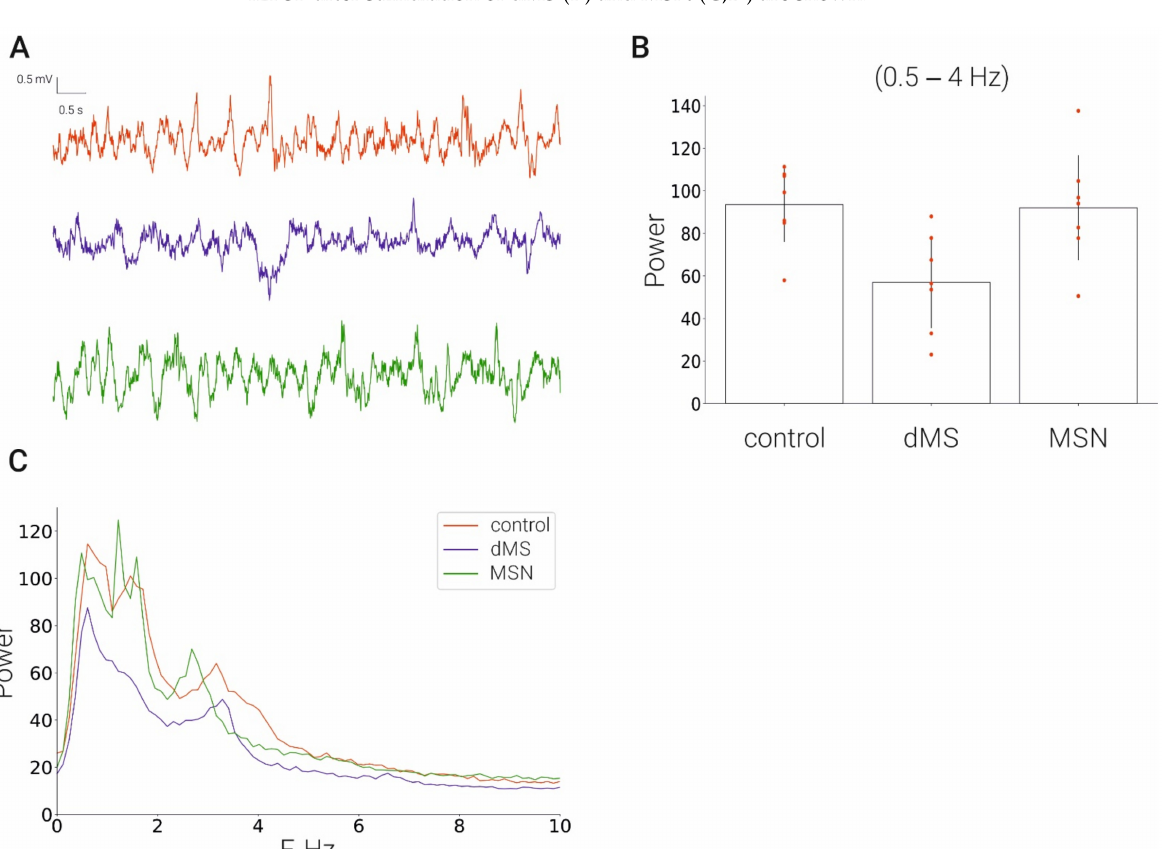
Figure 1. Field responses recorded in the hippocampal CA1 area following stimulation of medial septal area at different depths. Panel ( A ) shows localization of stimulating electrodes. Examples of fEPSP after stimulation of dMS ( B ) and MSN ( C , D ) are shown.